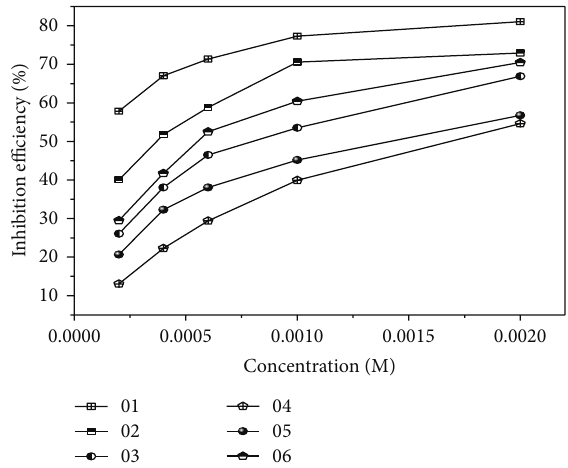
Figure 1: Variation of inhibition efficiency with inhibitor (01–06) concentration for mild steel in 1N H 2 SO 4 at 300 ± 1